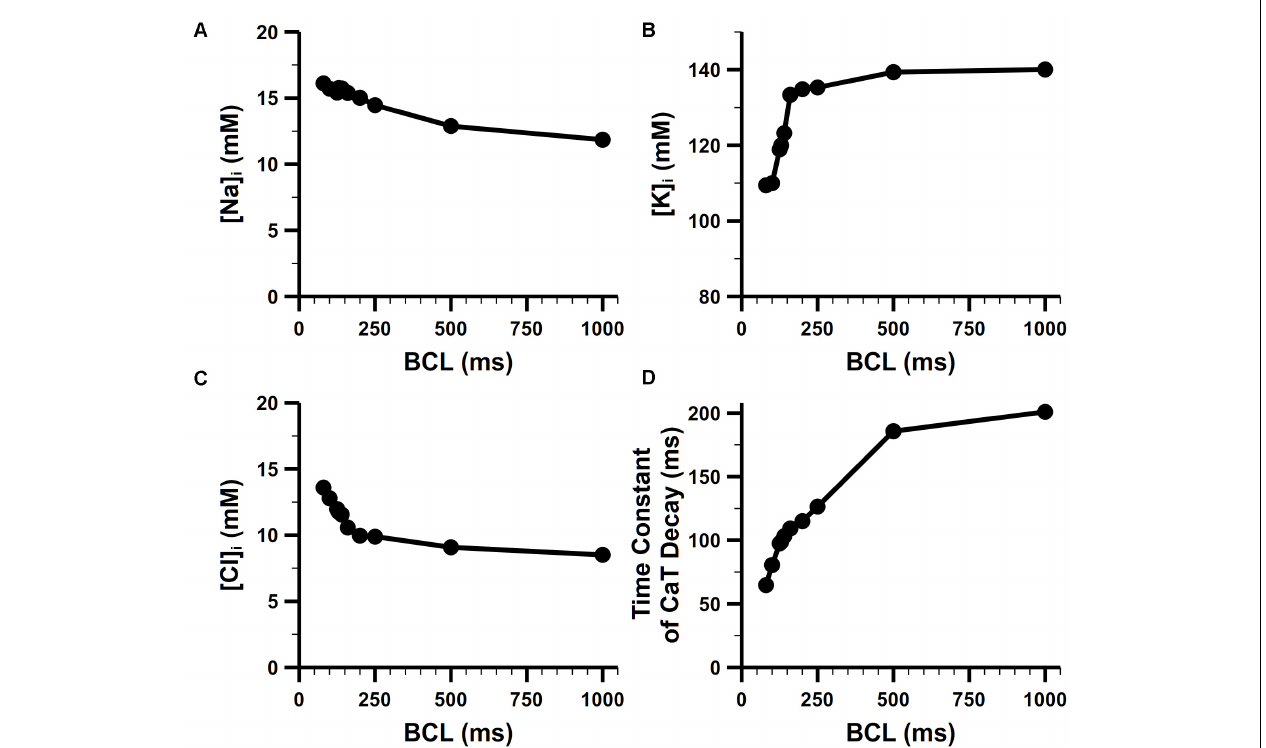
FIGURE 10 | Steady-state rate dependence of intracellular ion concentrations. Rate dependence of (A) [Na] i , (B) [K] i , and (C) [Cl] i . (D) Rate dependence of the time constant of CaT decay.